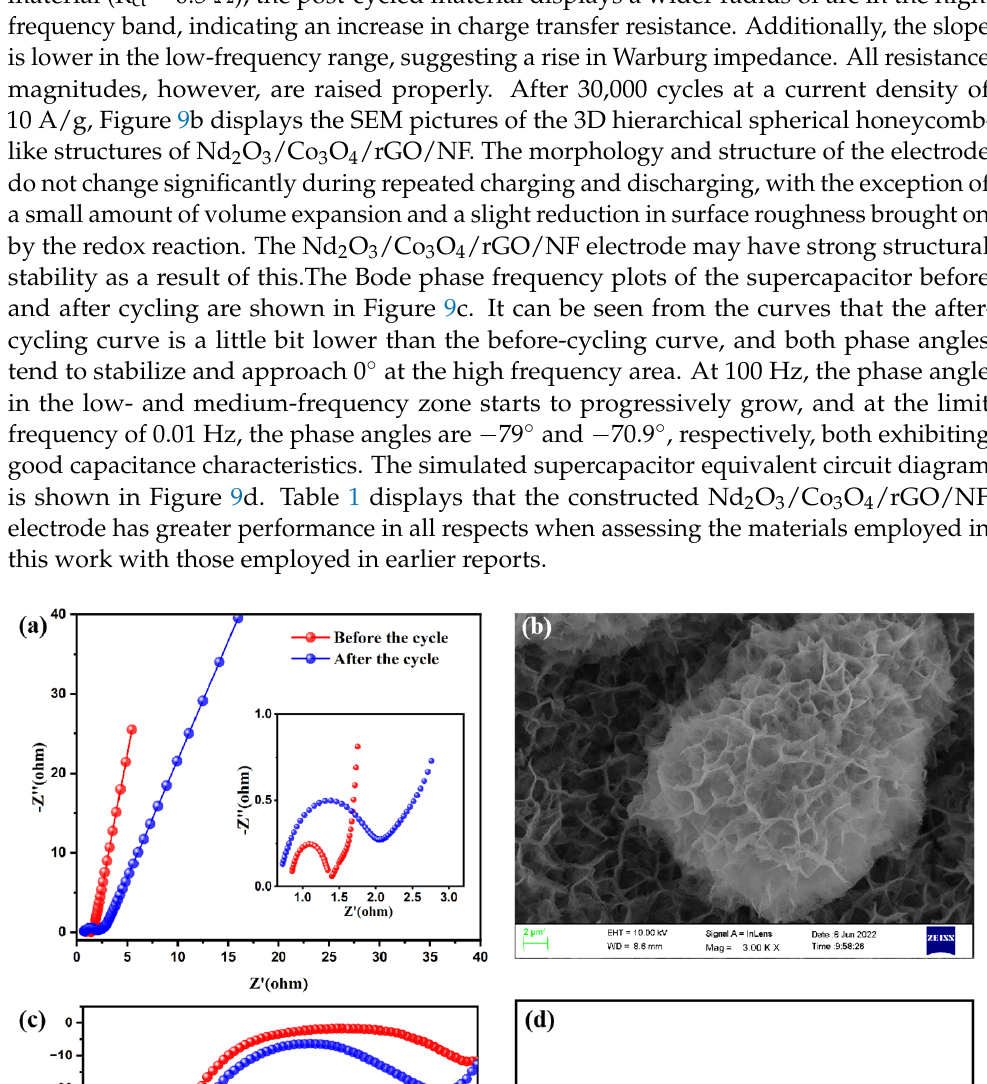
Table 1. Comparison of electrochemical performances of Nd 2 O 3 /Co 3 O 4 /rGO/NF composite electrode in our work with previous reports.